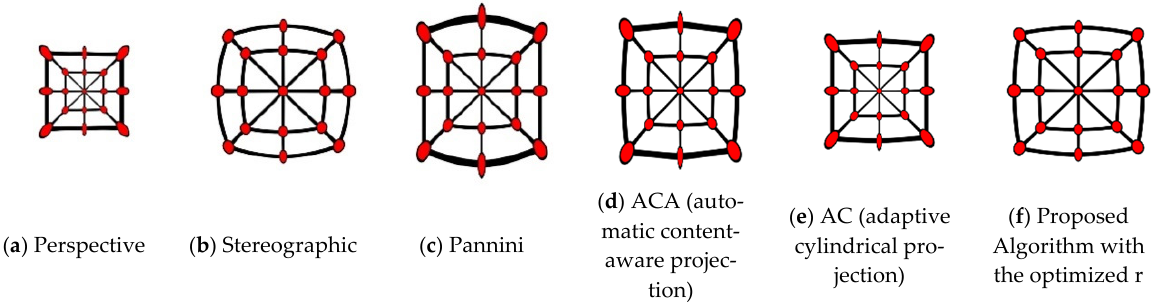
Figure 16. Test patterns produced by the various algorithms.